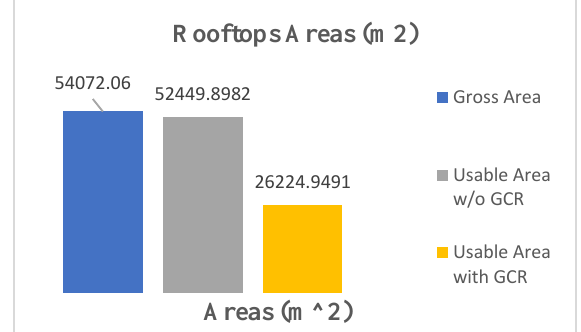
Figure 8 . Calculations of areas of rooftops.